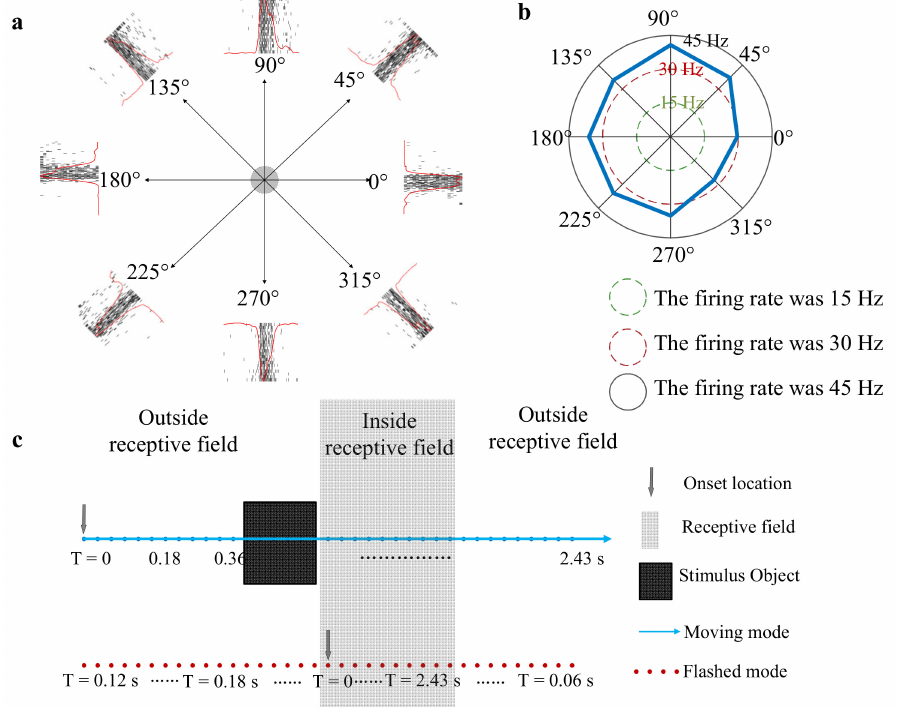
Figure 4. Directional tuning curves and paradigm of stimulus. ( a ) A square stimulus (stimulus A) moves in eight directions through the receptive field center. The shaded center (gray) is the receptive field center of the recorded unit. The arrows denote the moving direction of the square. The outer surroundings presented the firing spike train as well as its post-stimulus time histogram in 20 repeats of a moving square in each direction. ( b ) An example of tuning curves in eight directions. The blue line is the firing rate, and the green, red and black circles represent firing rates (spike counts in 1 s) of 15, 30 and 45, respectively. ( c ) An illustration of stimuli B and stimuli C in visual space. The grey area delimits the receptive field, with the square’s location marked by a black dot. A line of blue dots is the trajectory of motion stimulus and the arrow indicates the starting position of the moving square (stimuli B). A line of red dots is the location of the flashed stimulus, which is presented in a pseudo-random sequence (stimuli